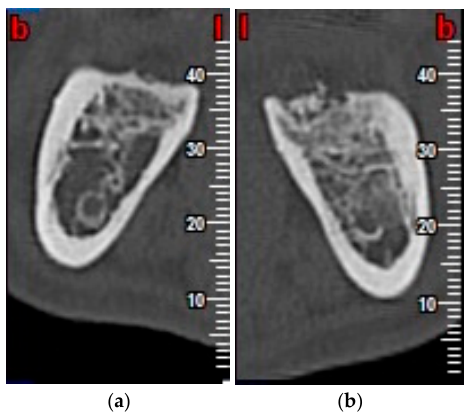
Figure 6. Cone beam computerized tomography scan (CBCT) scan, taken six months after lower third molar (LTM) extraction, in control group ( a ) and test group ( b ).